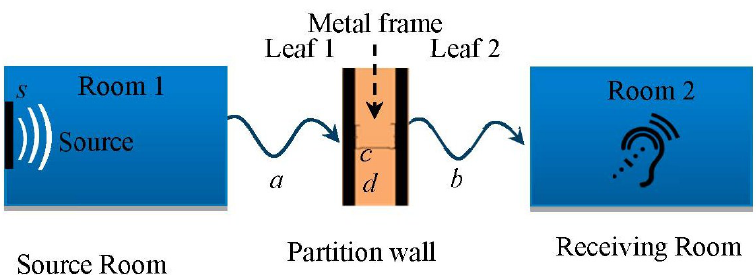
Figure 2. FSI between different components of the system considered; where s represents FSI between sound source and room air 1, a represents FSI between room air 1 and Leaf 1, b represents FSI between Leaf 2 and room air 2, c represents FSI between the stud and cavity air, and d represents FSI between cavity air and the two